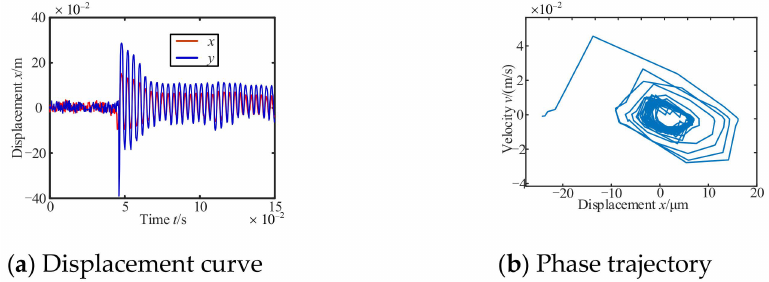
Figure 13. Displacement curve and phase trajectory under i 0 = 1.0 A.